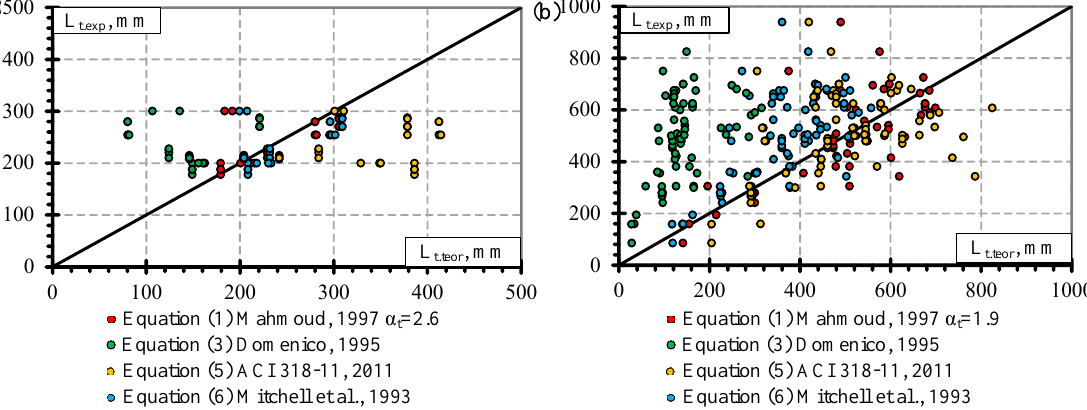
Figure 8. Relationship between the experimental and theoretical transfer lengths of ( a ) GFRP rein- forcement and ( b ) CFRP reinforcement [30,31,63,64].